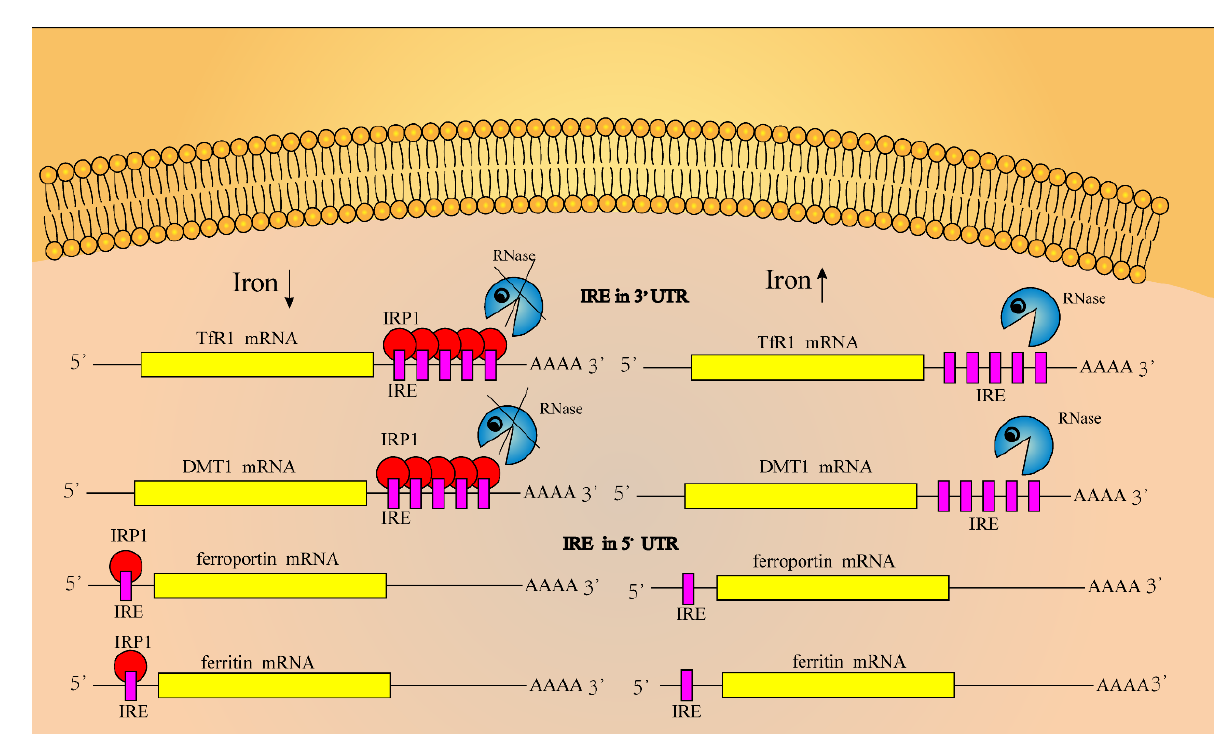
Figure 3. Regulation of iron homeostasis in cells. IREs are located in the 3 ′ -UTR region of TfR1 and DMT1 mRNAs, whereas they are located in the 5 ′ -UTR region of ferroportin and ferritin mRNAs. The combination of IRP and IRE regulates the iron ion concentration in the cell. When the iron ion concentration in the cell is too high, it will induce conformation changes in the untranslated region of mRNAs, making IRPs unable to bind to the IRE region; then, mRNAs of TfR1 and DMT1 are degraded, and the expression level of ferroportin and ferritin increases. On the other hand, iron ions bind to IRP1, and can form iron–sulfur clusters in IRP1 that exhibit cytoplasmic aconitase activity. In contrast, when the iron concentration in the cell decreases, the binding ability of IRP and IRE is enhanced, which leads to a decreased expression of ferroportin and ferritin proteins, and an increased expression of TfR1 and DMT1.